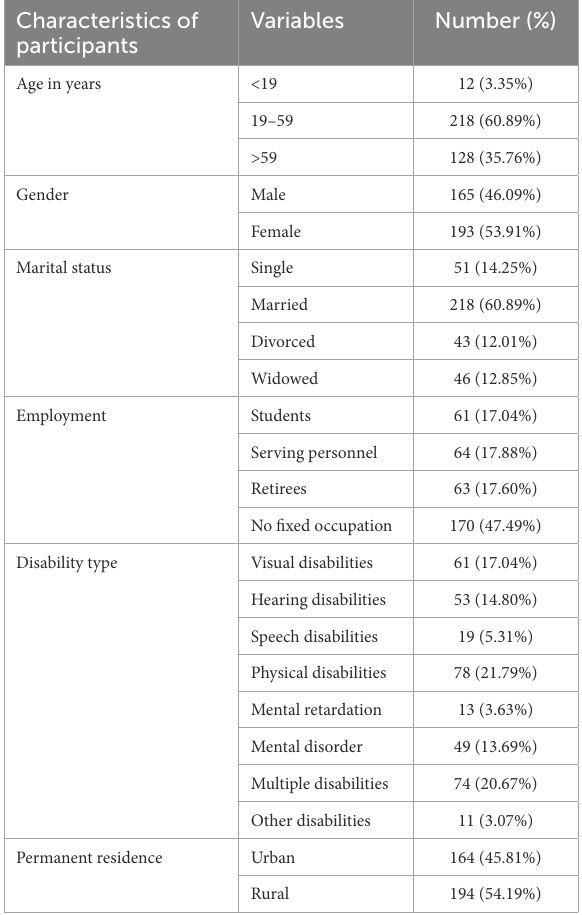
TABLE 1 Sample characteristics ( N =